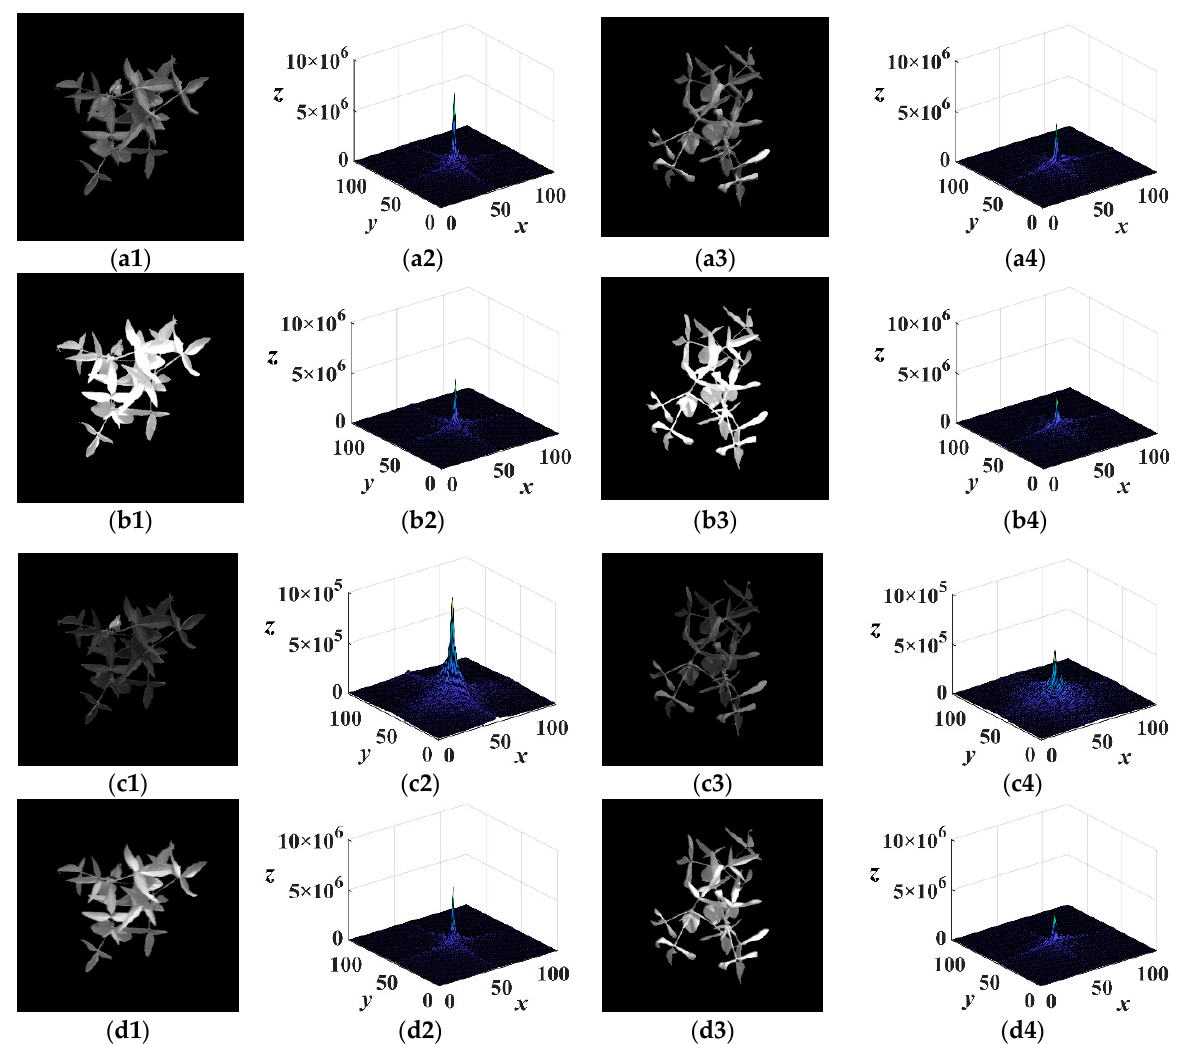
Figure 16. Soybean canopy and corresponding spectrum: ( a1 ) GRE canopy under normal treatment, ( a2 ) GRE spectrum under normal treatment, ( a3 ) GRE canopy under drought treatment, ( a4 ) GRE spectrum under drought treatment, ( b1 ) NIR canopy under normal treatment, ( b2 ) NIR spectrum under normal treatment, ( b3 ) NIR canopy under drought treatment, ( b4 ) NIR spectrum under drought treatment, ( c1 ) RED canopy under normal treatment, ( c2 ) RED spectrum under normal treatment, ( c3 ) RED canopy under drought treatment, ( c4 ) RED spectrum under drought treatment, ( d1 ) REG canopy under normal treatment, ( d2 ) REG spectrum under normal treatment, ( d3 ) REG canopy under drought treatment and ( d4 ) REG spectrum under drought treatment.